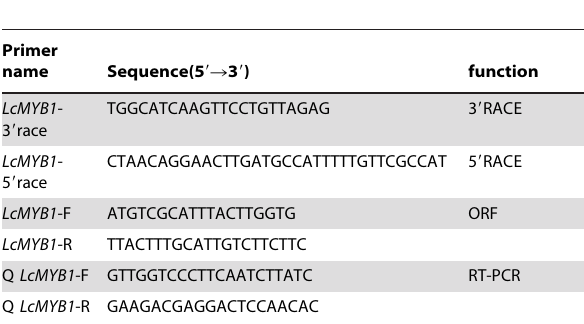
Table 2. LcMYB1 3 9 RACE, 5 9 RACE, ORF and RT-PCR primers used in this study.